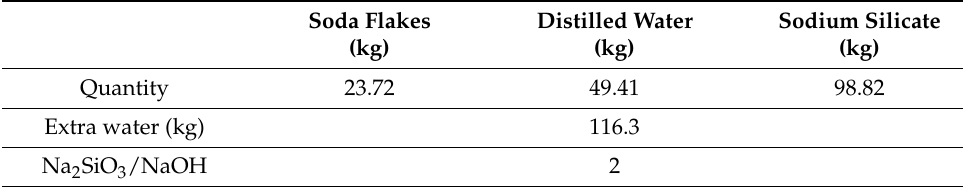
Table 3. Ingredients for 12 M NaOH in 1 m 3 of the